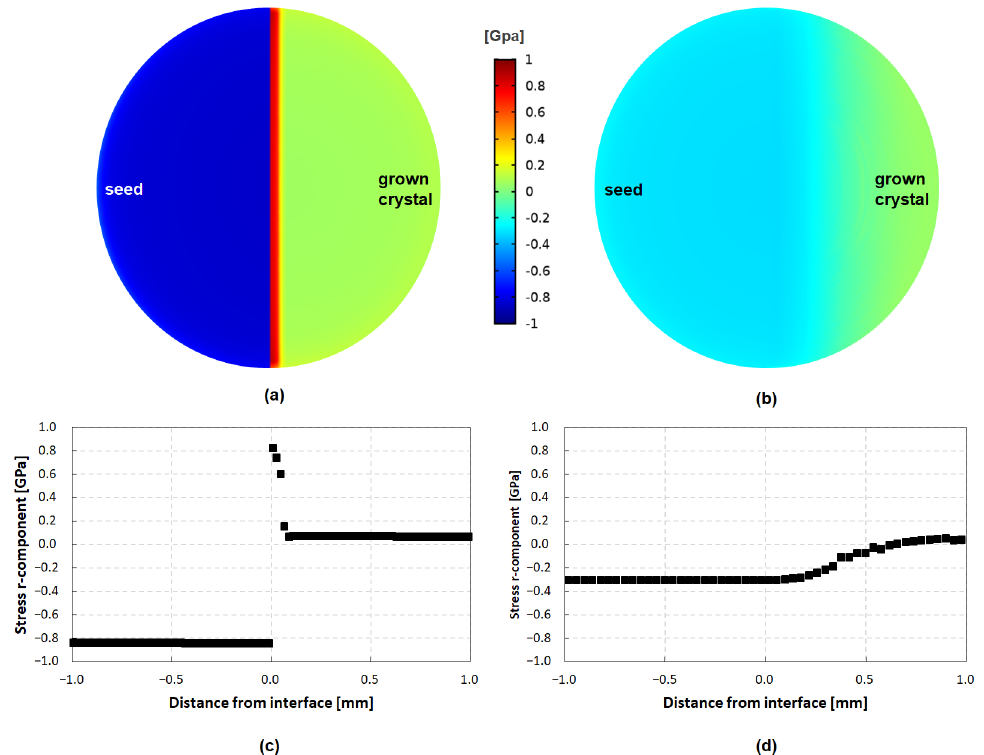
Figure 8. Calculated r-component stress across the seed–crystal interface of ( a ) crystal A and ( b ) crystal B, calculated from Raman measurements and considering the change in CTE caused by changing doping concentrations. A positive distance from interface marks the area of grown crystal, while a negative distance marks the seed portion of the crystal. The plotted r-component over the distance from the interface is illustrated for crystal A and crystal B in ( c , d ), respectively. A positive value indicates a tensile stress while compressive stress is illustrated by positive values.